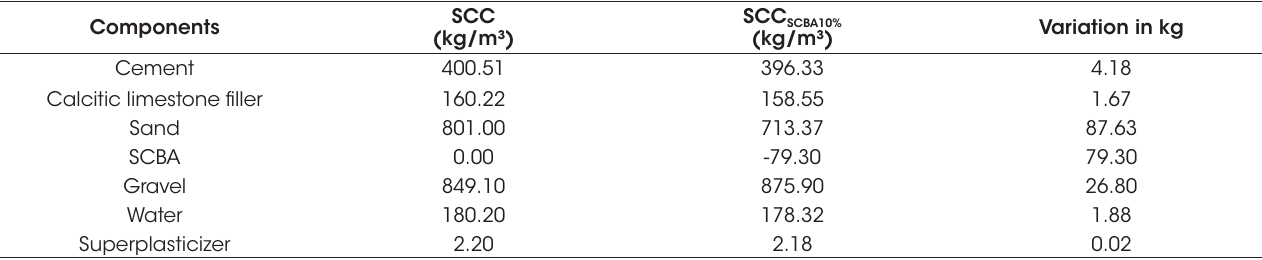
Materials consumption for 1 m³ of concrete Components Cement Calcitic limestone filler